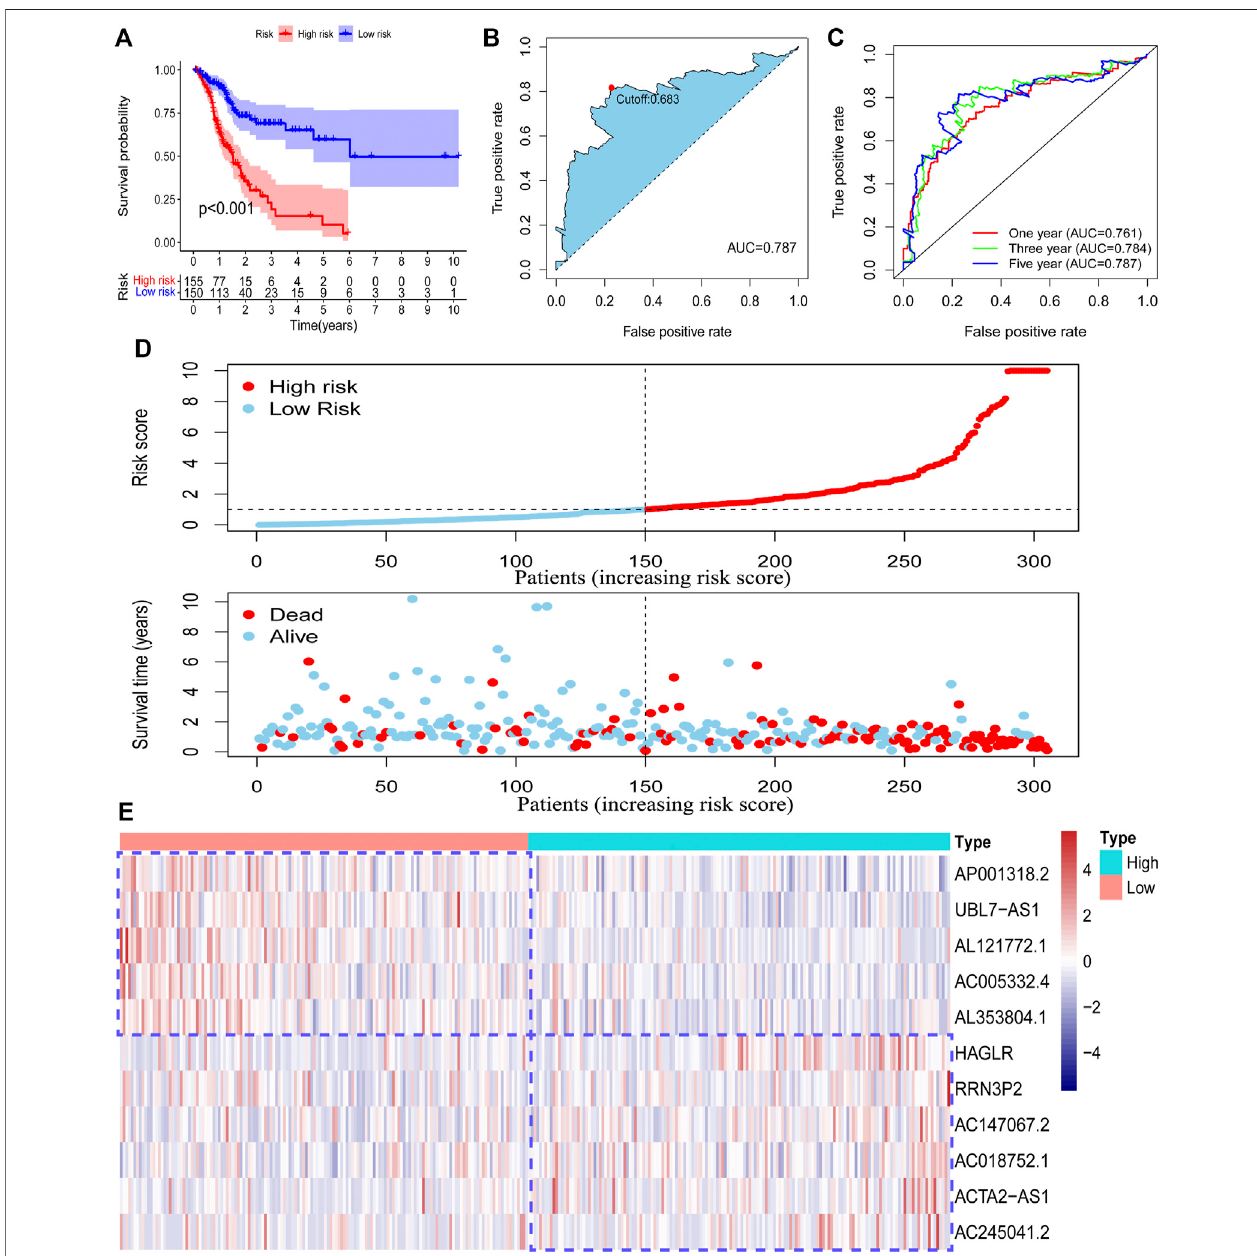
FIGURE 4 | Validation of the risk model in the entire set. The survival difference between the low-risk patients and high-risk patients in the entire set (A) . A time- dependent ROC curve was plotted to test the accuracy of the risk model (B, C) . The survival status difference of the patients between the low-risk and high-risk groups was visualized (D) . The RNA level of the 11 pyroptosis-related lncRNAs in the entire set was visualized (E) .